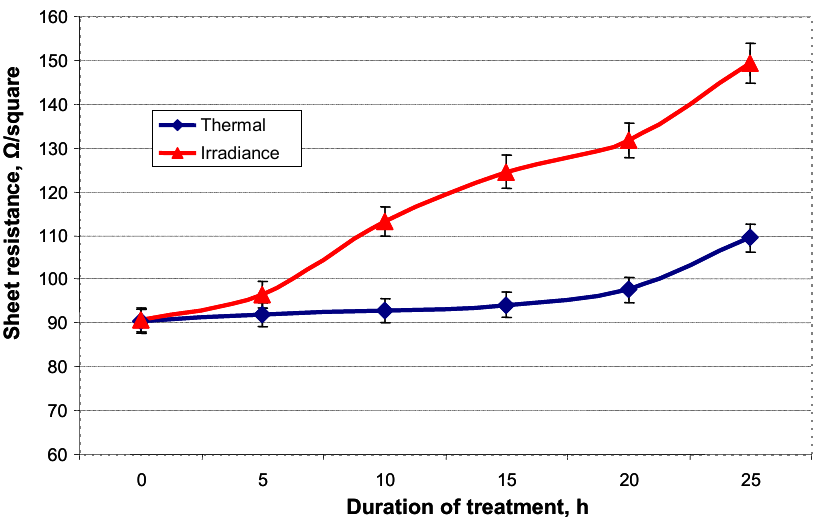
Figure 6. Electrical stability of the trilayer composite: sheet resistance after thermal and irradiance treatment for different time intervals.